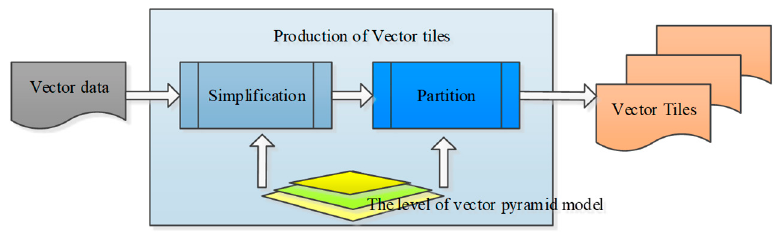
Figure 2. Construction of Vector tiled Pyramid Model.